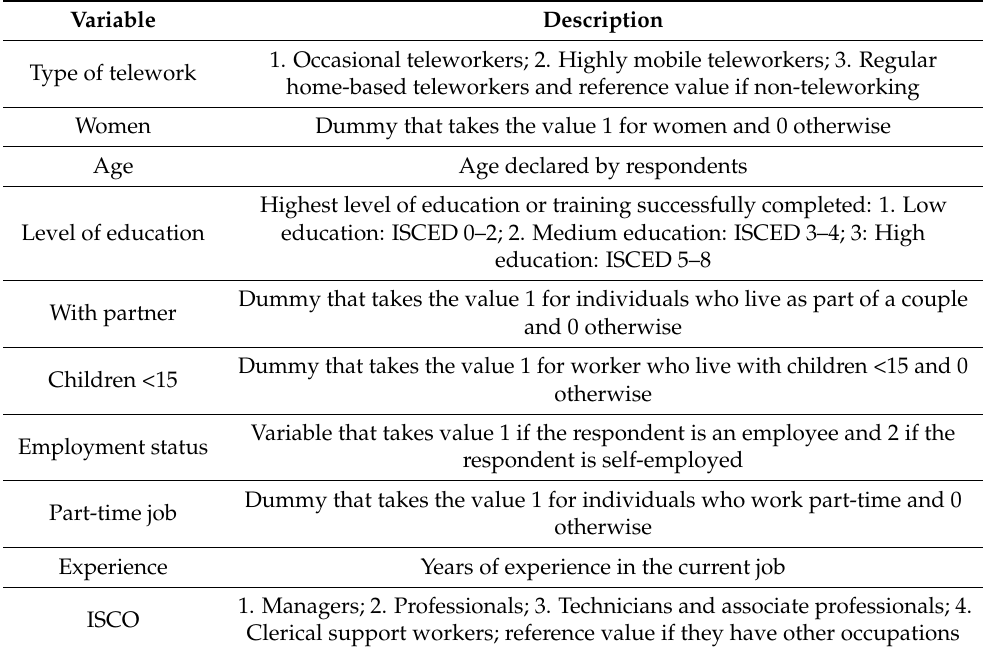
Table A1. Definitions of independent